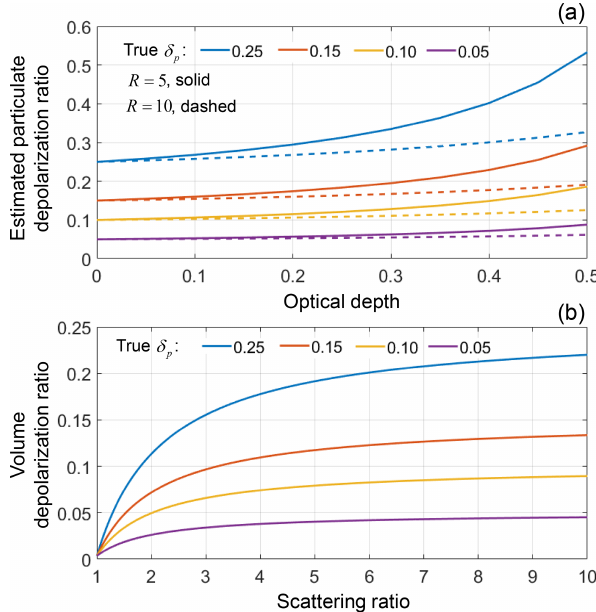
Figure 3. (a) Estimated particulate depolarization ratio as a function of optical depth for four values of the true particulate depolarization ratio in layers with unattenuated scattering ratios of 5 (solid lines) and 10 (dashed lines). (b) Volume depolarization ratio as a function of scattering ratio for four values of true particulate depolarization